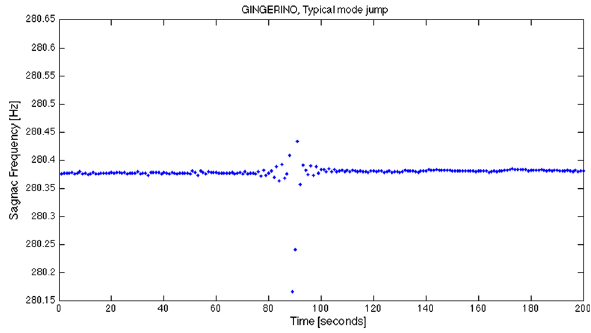
Fig. 7 GINGERINO Sagnac frequency around a typical mode